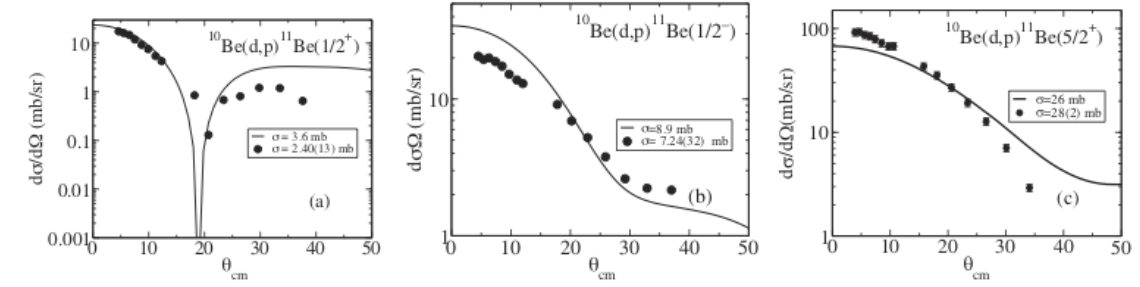
Figure 4. From [5]. Absolute di ff erential and (insets) integrated cross sections associated with the reactions d( 10 Be, 11 Be)p at E = 107 MeV, populating the 1 / 2 + , 1 / 2 − and 5 / 2 + low-lying states. The experimental data [9] are displayed in terms of solid dots.